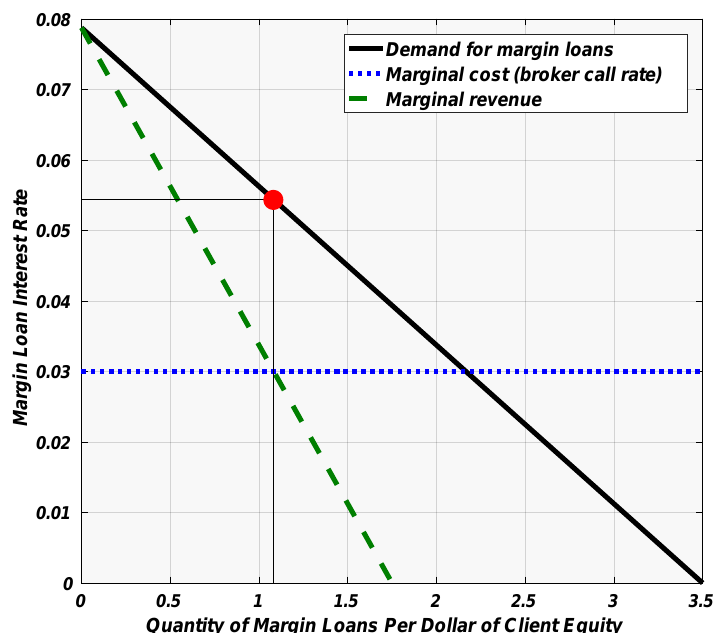
Figure 1. Kelly gambler’s instantaneous demand for margin loans per dollar of account equity, ν : = 0.09, σ : = 0.15, µ : = ν + σ 2 /2, r : = 0.03.